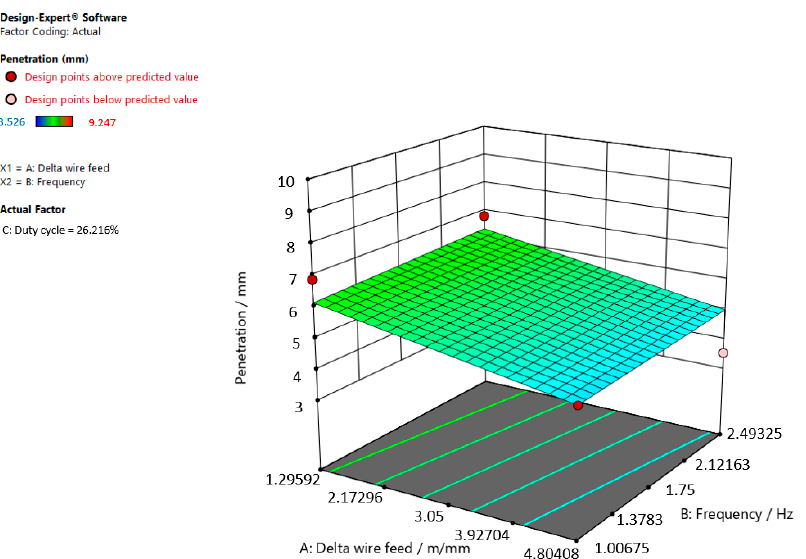
Figure 6. Response surface for the regression model of weld penetration at a duty cycle of 26.216%.